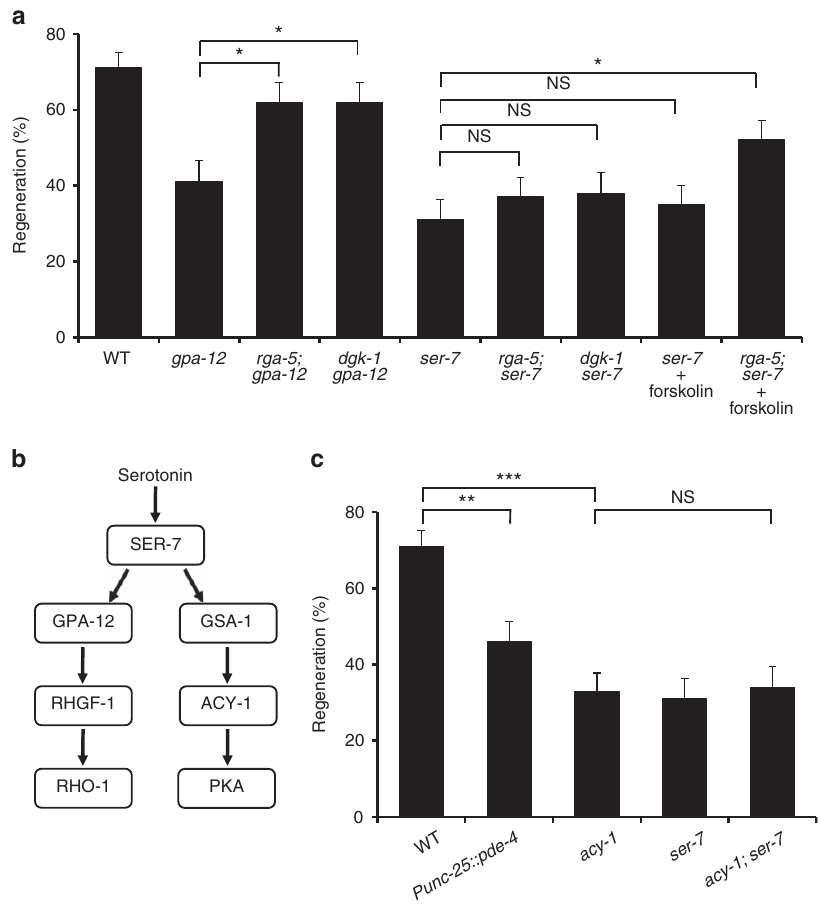
Figure 5 | SER-7 promotes axon regeneration via the cAMP pathway. ( a , c ) Percentages of axons that initiated regeneration 24h after laser surgery. Error bars indicate 95% CI. *** P o 0.001; ** P o 0.01; * P o 0.05; NS, not significant (Fisher’s exact test, two-tailed, n Z 50). ( b ) SER-7 signalling pathways. SER-7 activates both GPA-12-RHGF-1-RHO-1 and GSA-1-ACY-1-PKA